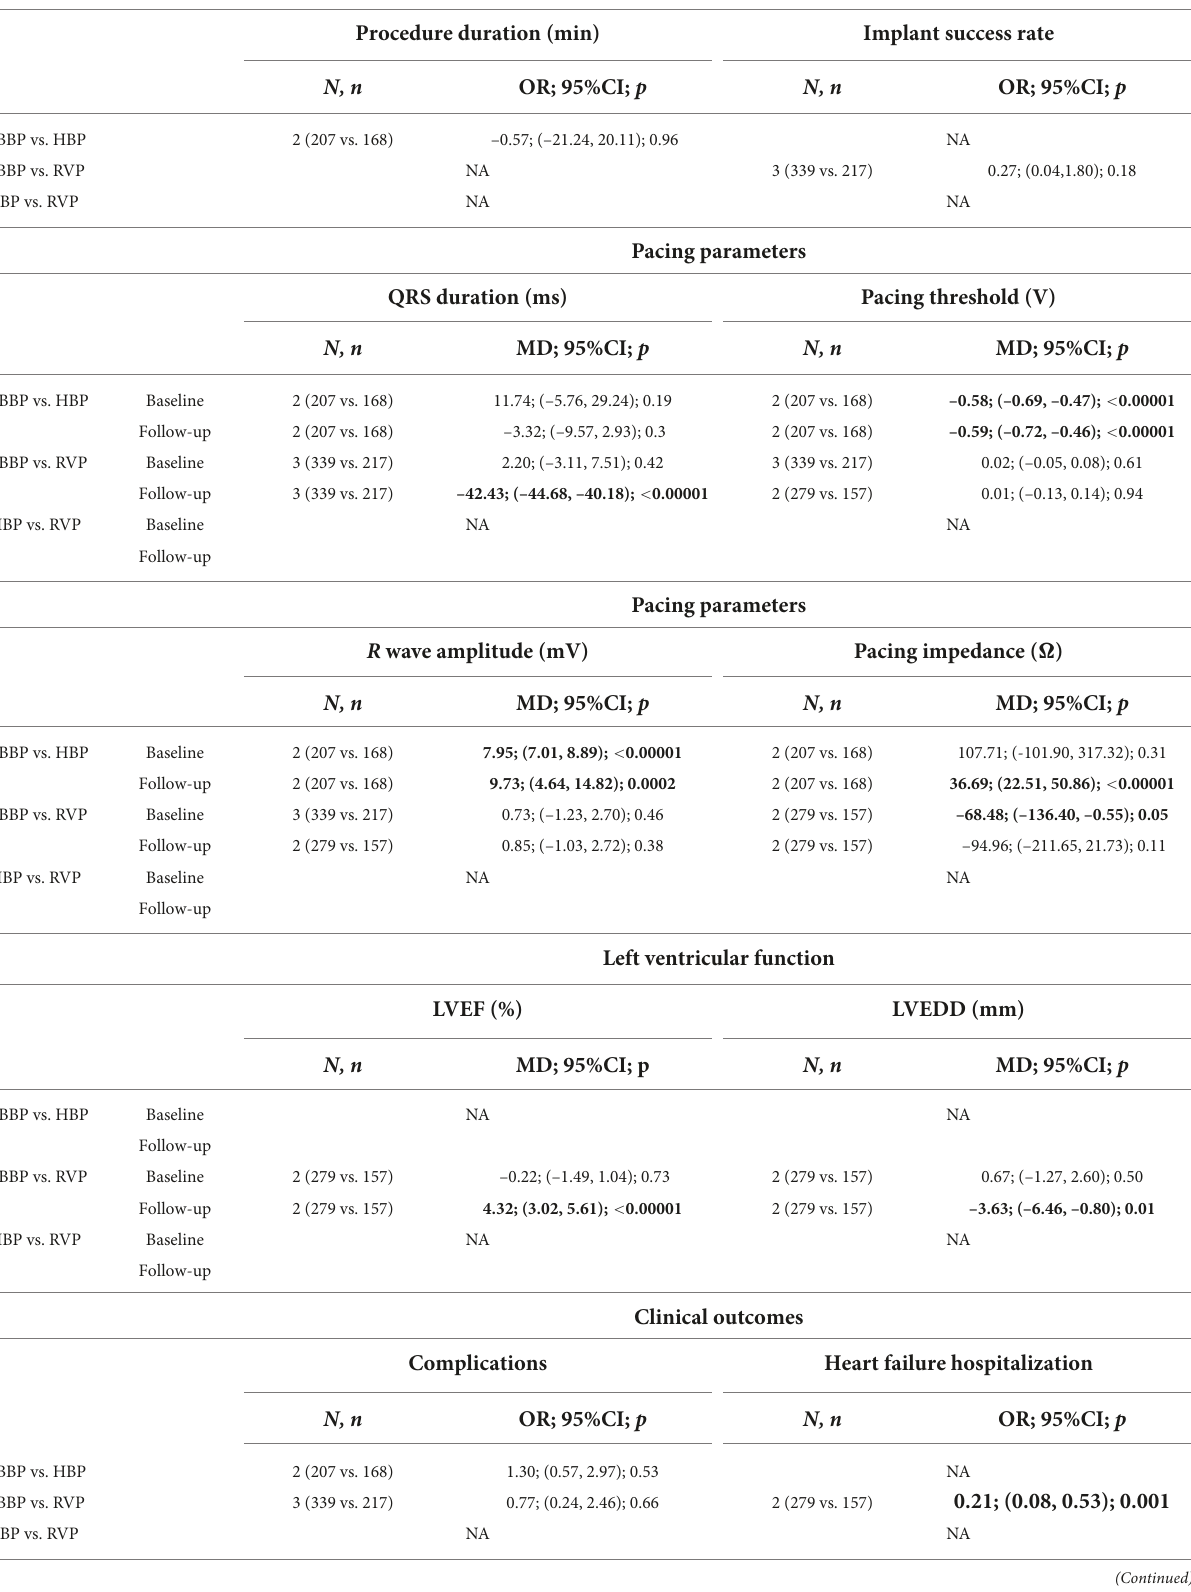
TABLE 2 Results of pairwise